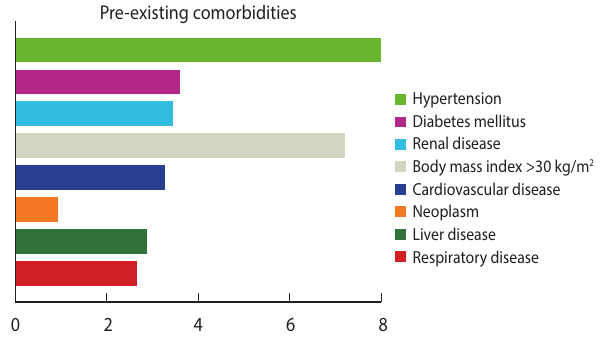
Figure 2. Mean proportion of patients with different comorbidities in the included studies.